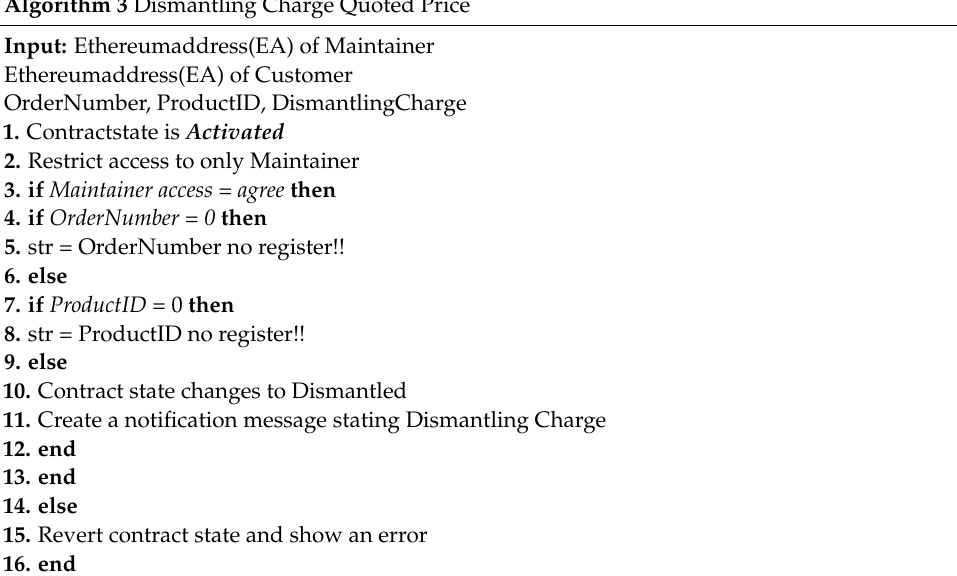
Algorithm 3 Dismantling Charge Quoted